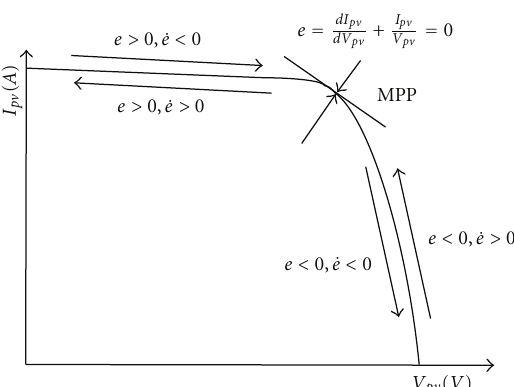
Figure 3: Change diagram of I - V characteristic curve of slope error e and the change in slope error ˙ e .